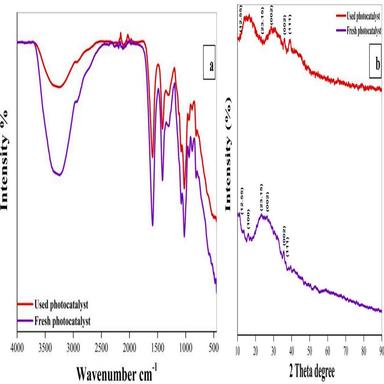
(a) FT-IR and (b) XRD studies of photocatalyst before and after degradation reaction.